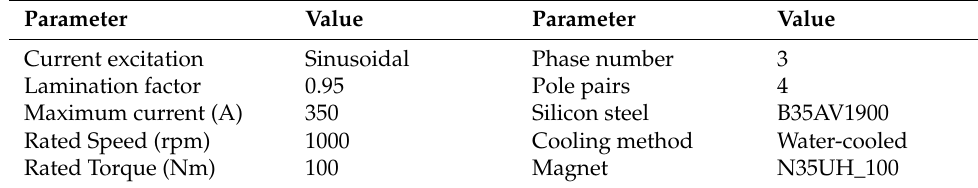
The motor parameters are listed in the Table 1: Table 1. Motor